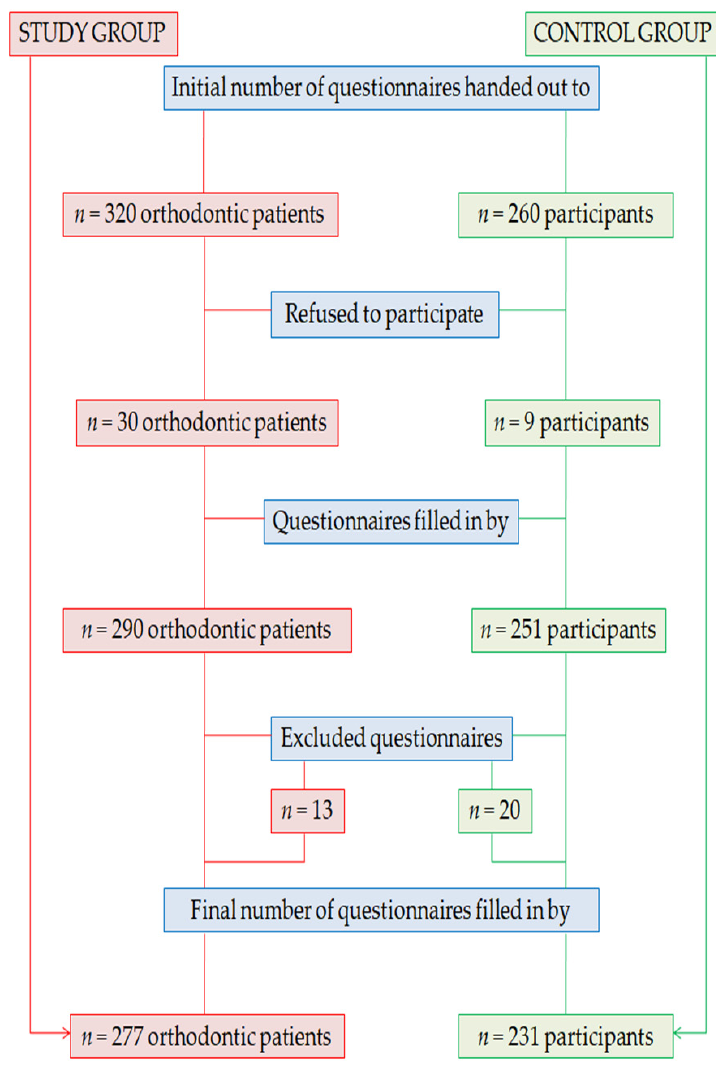
Figure 1. Study flowchart.